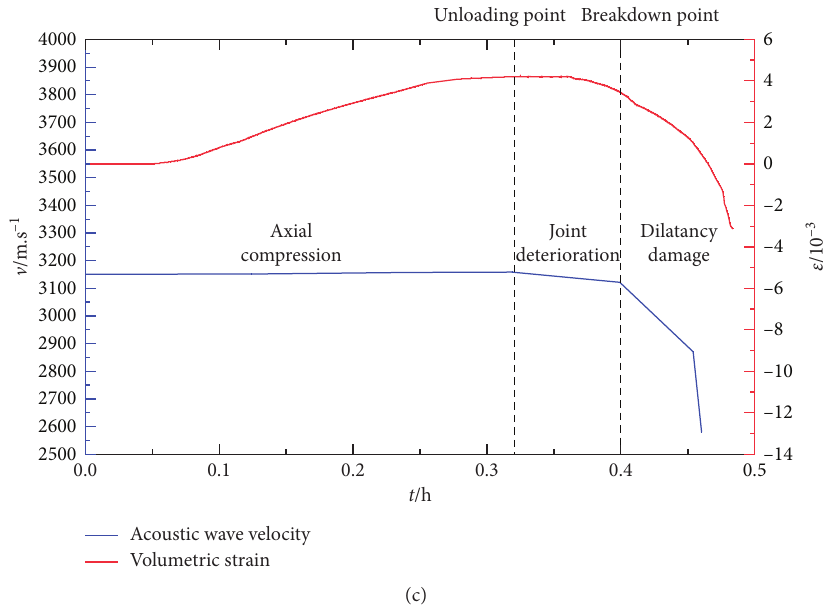
Figure 14: Variations of AW velocity and volumetric strain under different initial confining pressures. (a) 4 MPa, (b) 6MPa, and (c)